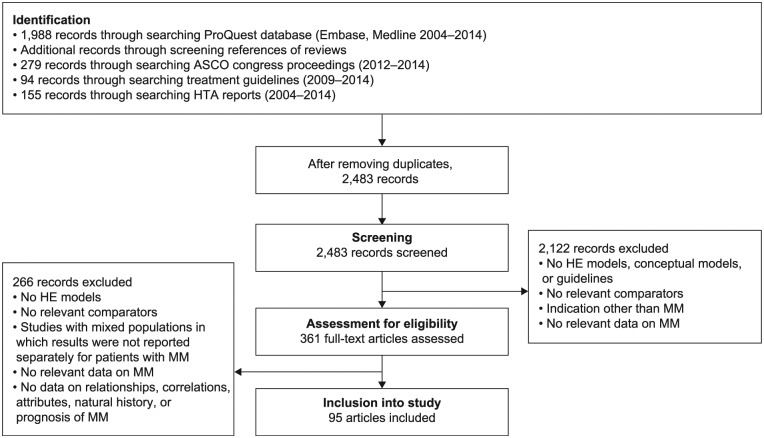
PRISMA flow chart of the systematic literature searches.ASCO, American Society of Clinical Oncology; HE, health economics; HTA,
health technology assessment; MM, multiple myeloma; PRISMA, Preferred
Reporting Items for Systematic Reviews and Meta-Analyses.